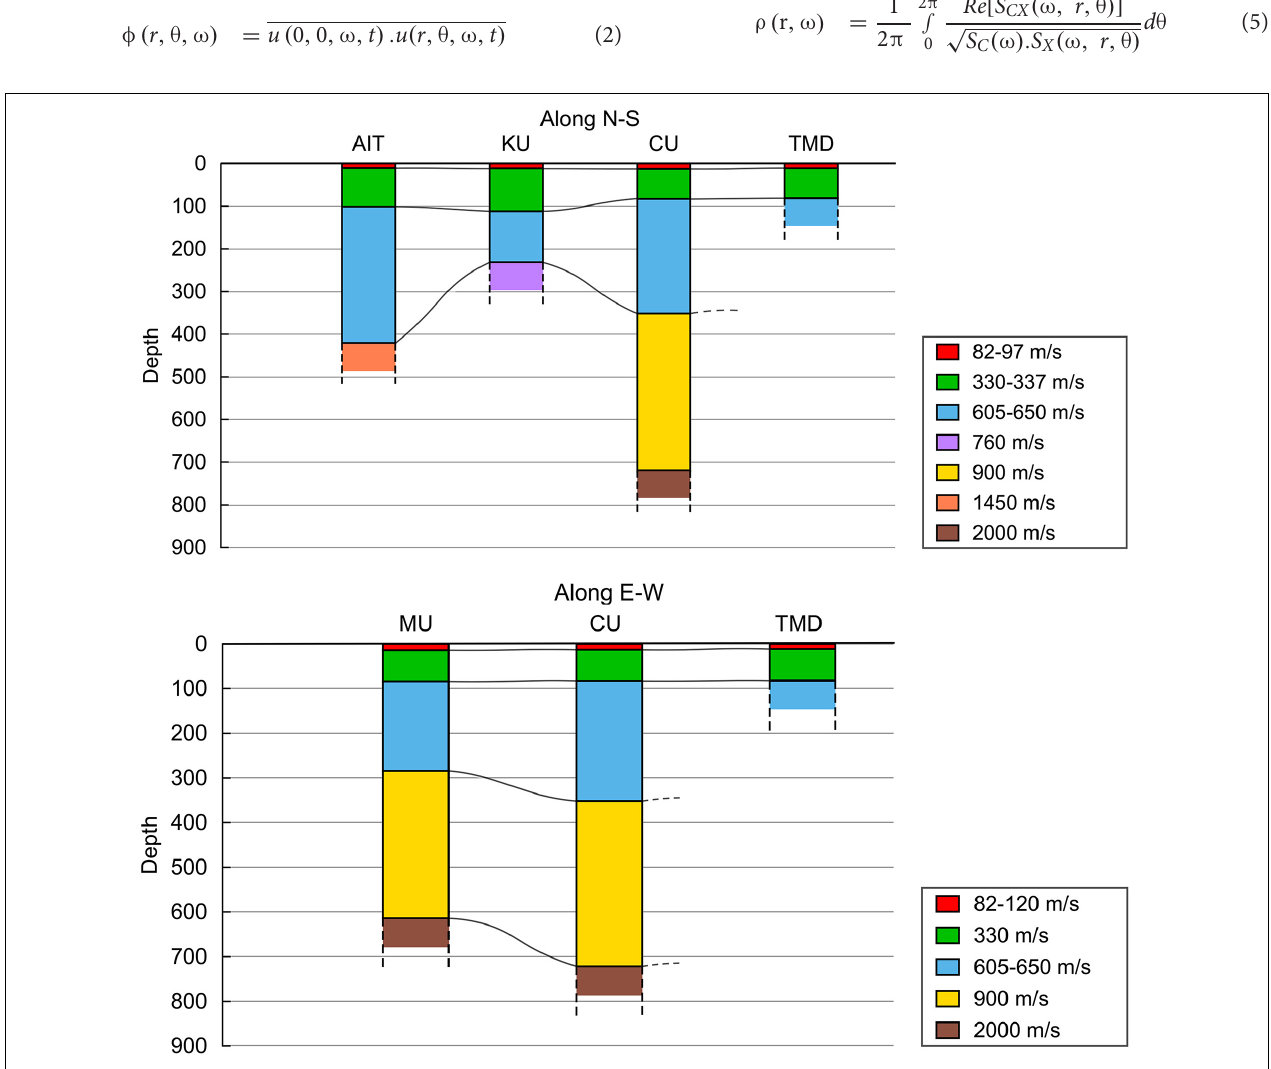
FIGURE 10 | S-wave velocity profiles along the N–S and E–W lines shown in Figure 3 .